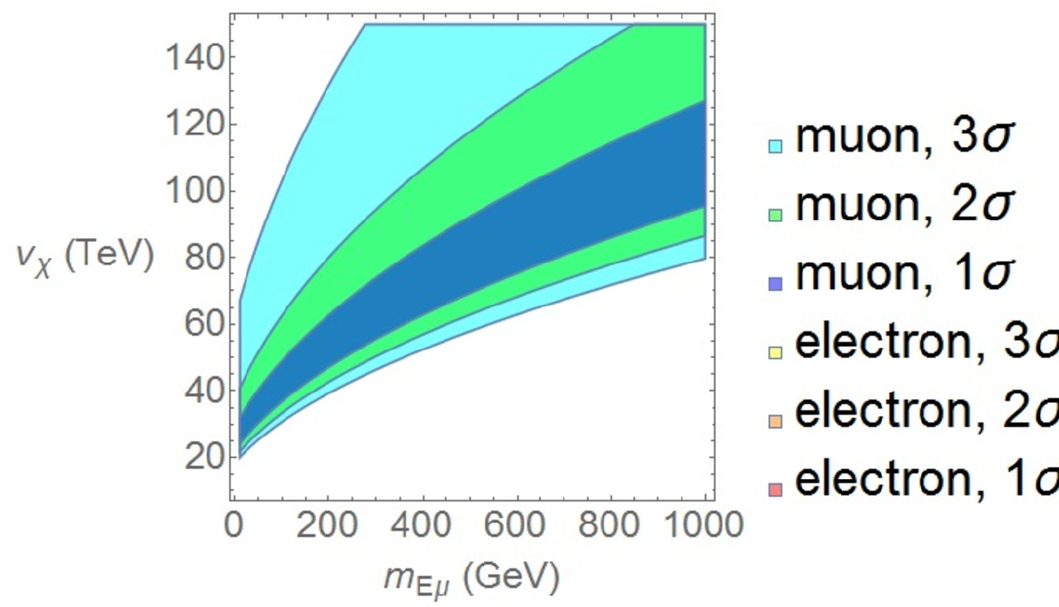
Figure 10 . Same as in (cid:12)gure 9 but now with m E